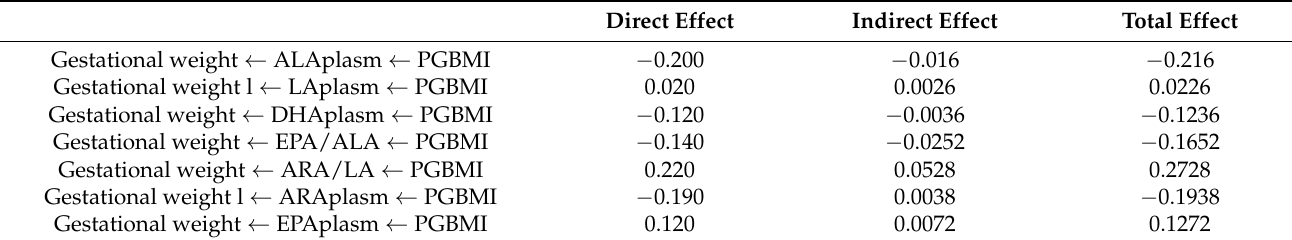
Table 3. Direct, indirect, and total effect of the PUFA concentrations on the weight gain construct intermediated by PGBMI. Santo Ant ô nio de Jesus, Bahia, 2013–2014. Direct Effect Indirect Effect Total